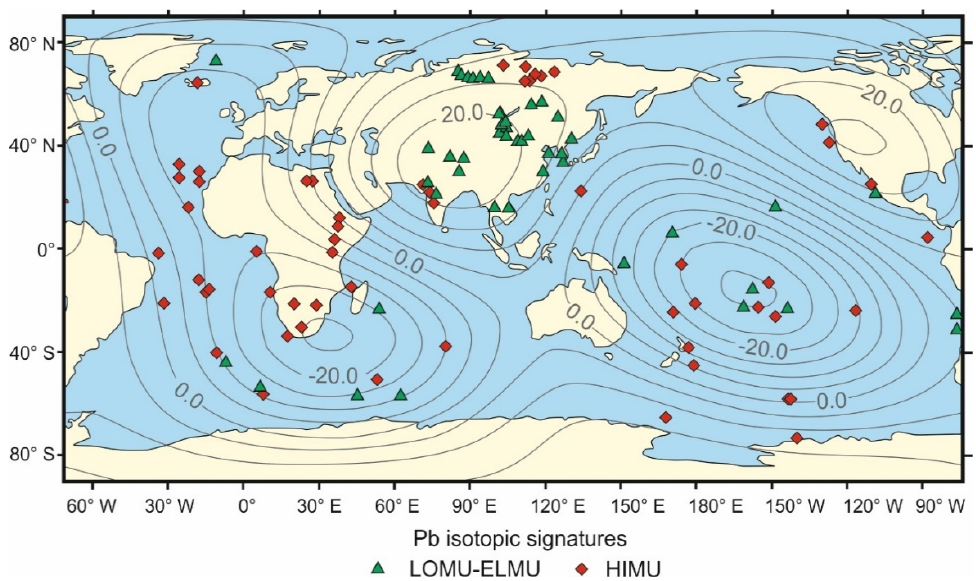
Figure 18. Distribution of melting anomalies with LOMU–ELMU signatures in the Asian high-velocity domain and those with HIMU signatures in the South Pacific and African low-velocity domains. Isolines of the P-wave velocities averaged over the entire lower mantle are shown after [1]. Indicated in Asia are the melting anomalies with the LOMU–ELMU and HIMU signatures of Figure 1 and in other regions of the world are those adopted from the reviews by Jackson et al. [5] and Homrighausen et al. [6].